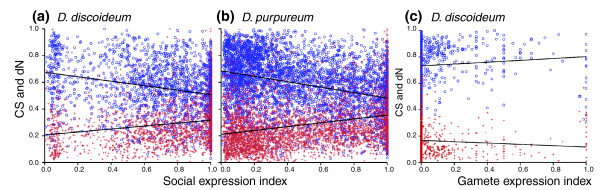
Conservation score (CS, blue open circles) and non-synonymous substitution rate (dN, red crosses) as a function of the degree of a gene's expression in social versus vegetative stages (a,b) or of sexual versus vegetative stages (c). (a) For D. discoideum RNA-seq reads (1,739 genes) both regressions are significant (CS, y = -0.17x + 0.68, R2 = 0.063, P < 0.0001; dN, y = 0.11x + 0.21, R2 = 0.032, P < 0.0001). (b) For D. purpureum RNA-seq reads (3,649 genes), both regressions are also significant (CS, y = -0.20x + 0.69, R2 = 0.11, P < 0.0001; dN, y = 0.14x + 0.21, R2 = 0.017, P < 0.0001). (c) Conservation score and non-synonymous substitution rate as a function of the percentage of D. discoideum ESTs expressed in the gamete stage (932 genes, including 835 and 16 genes with a gamete expression index of 0% and 100%, respectively). Both regressions are significant: CS, y = -0.0070x + 0.73, R2 = 0.0072, P < 0.01; dN, y = 0.00051x + 0.17, R2 = 0.00708, P = 0.01.